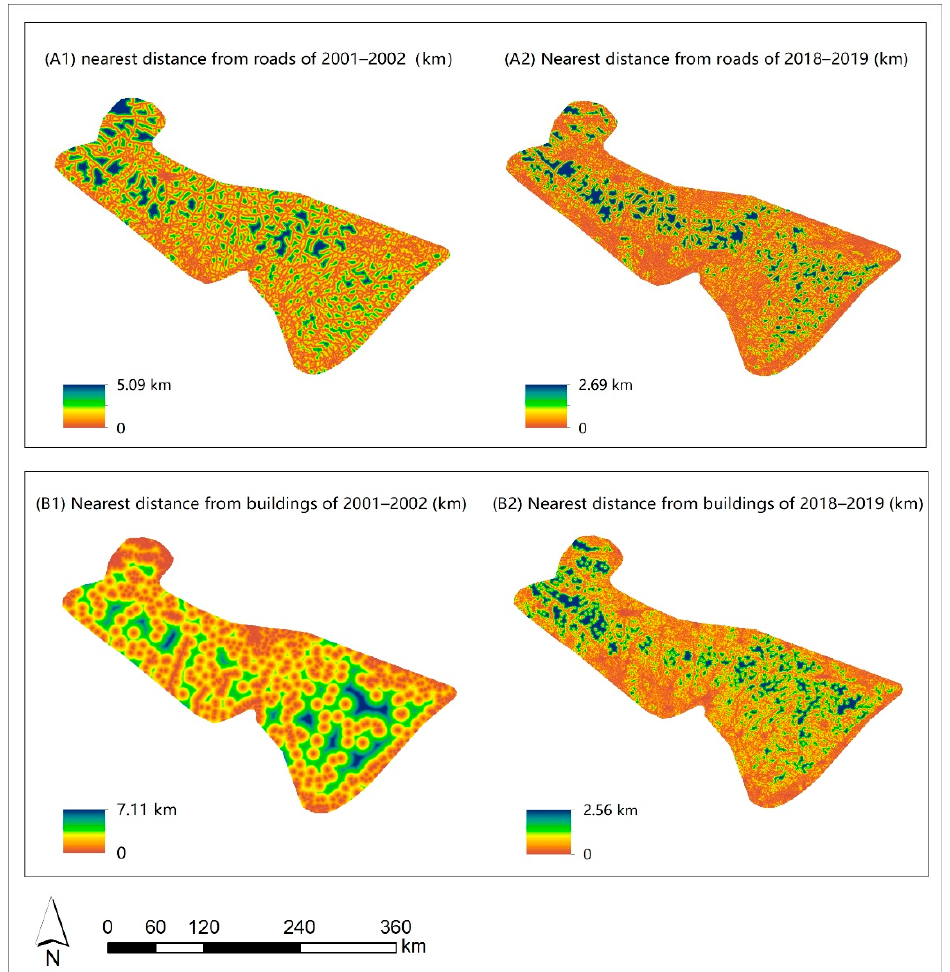
Figure 3. The distance to roads and buildings at the study area in the Dabie Mountains, China.